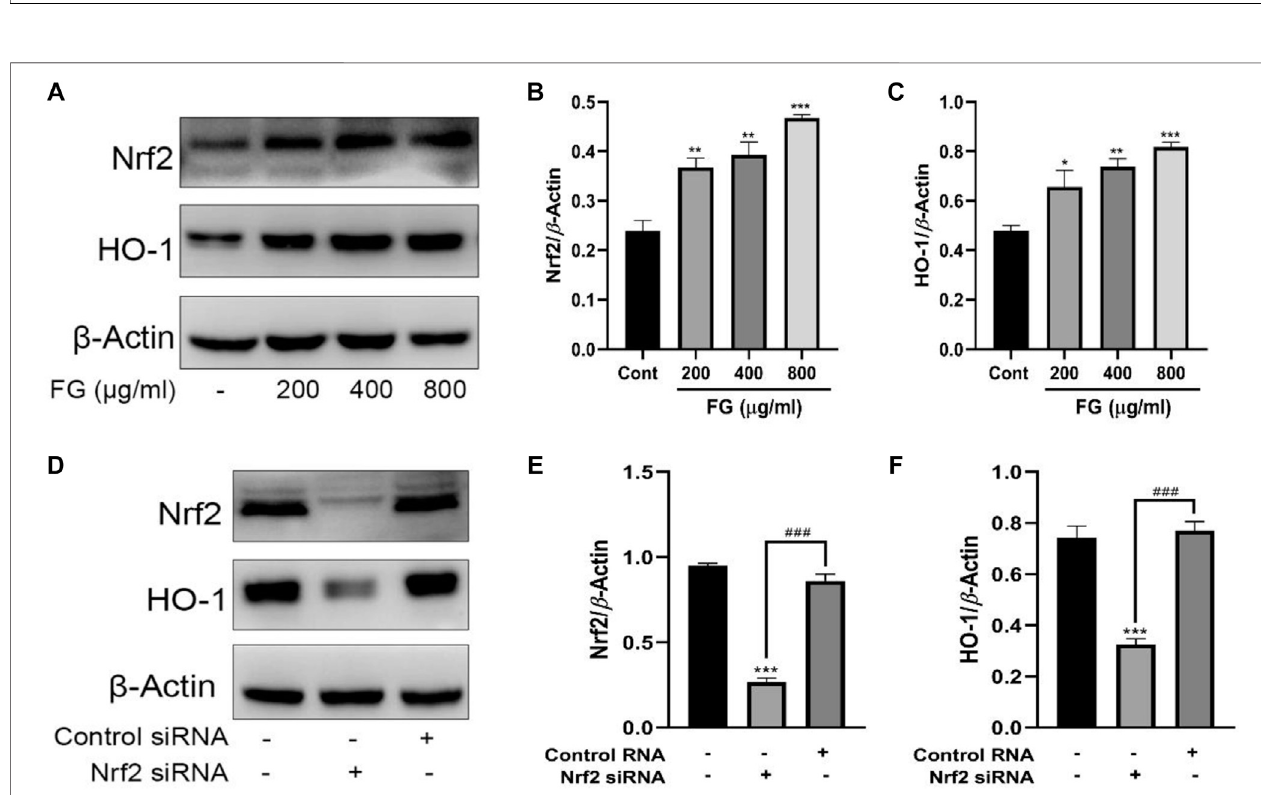
FIGURE 8 | Effects of FG on the expression of Nrf2 and HO-1 in BV2 microglia. BV2 cells were treated with FG extraction (200, 400, and 800 μ g/ml) for 24 h, and the expression ofNrf2and HO-1 wasmeasured byWesternblot (A – C) .Then theNrf2 geneofBV2cells wassilenced byNrf2siRNA or controlRNA,and theexpression of Nrf2 and HO-1 was evaluated by Western blot (D – F) . Results are expressed as mean ± SEM of three independent experiments (* p < 0.05, ** p < 0.01, *** p < 0.001, ### p < 0.001).